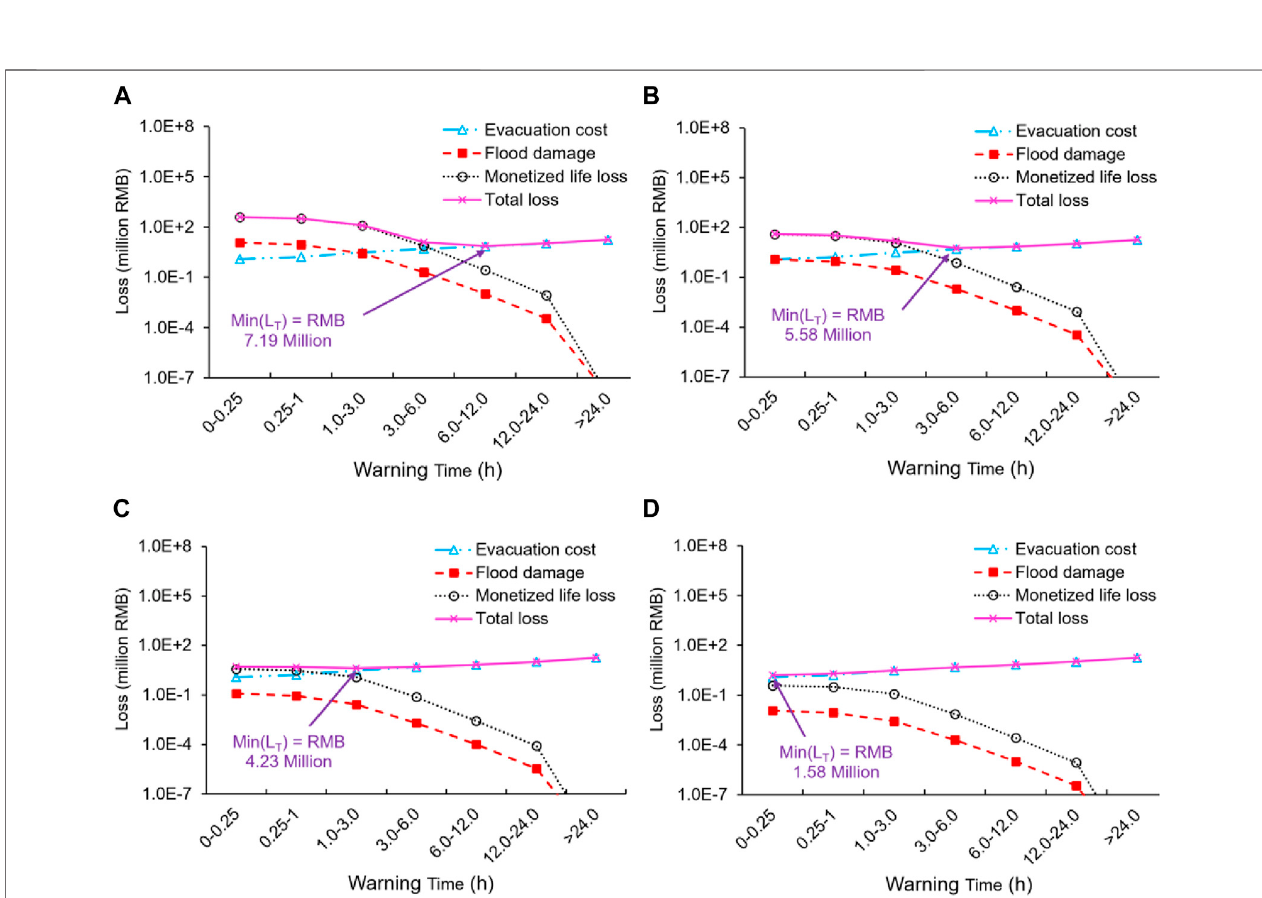
FIGURE 11 | Three types of losses and the total loss in Scenario 1 in Beichuan County with different dam failure probabilities: (A) P f (cid:2) 1; (B) P f (cid:2) 0.1; (C) P f (cid:2) 0.01; (D) P f (cid:2)